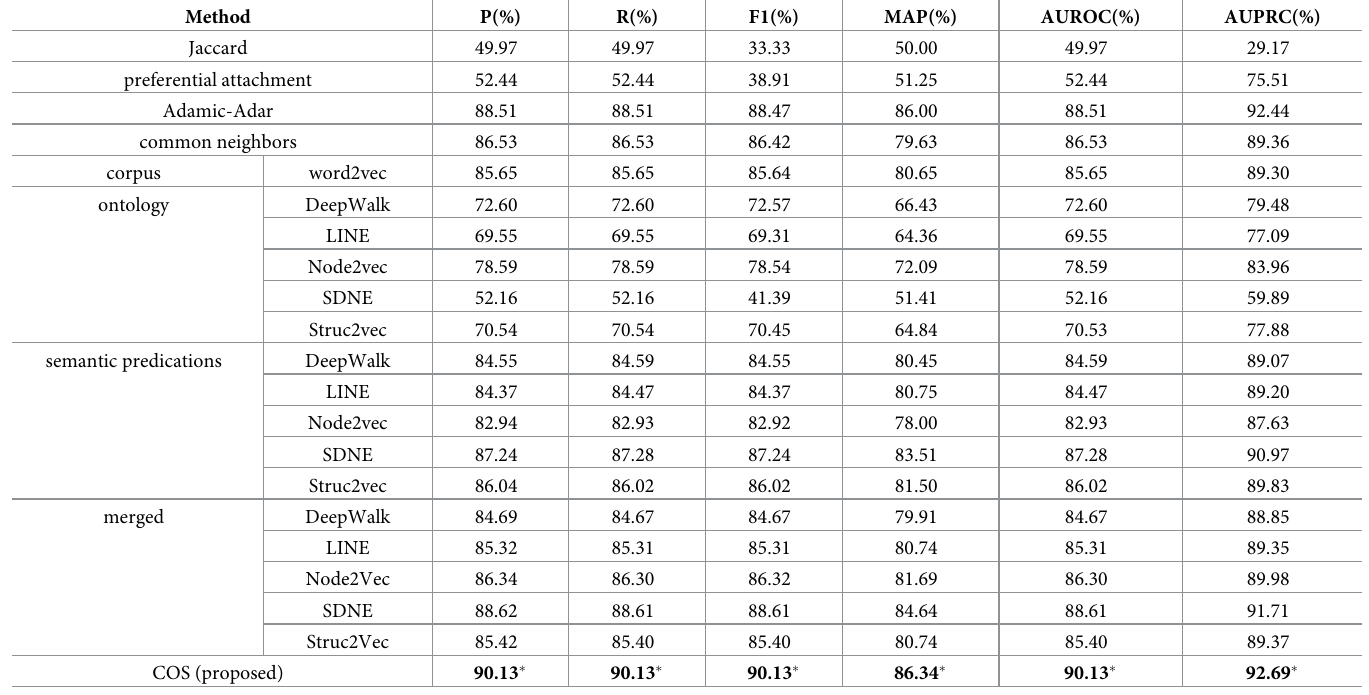
Table 5. Edge prediction results for interact.